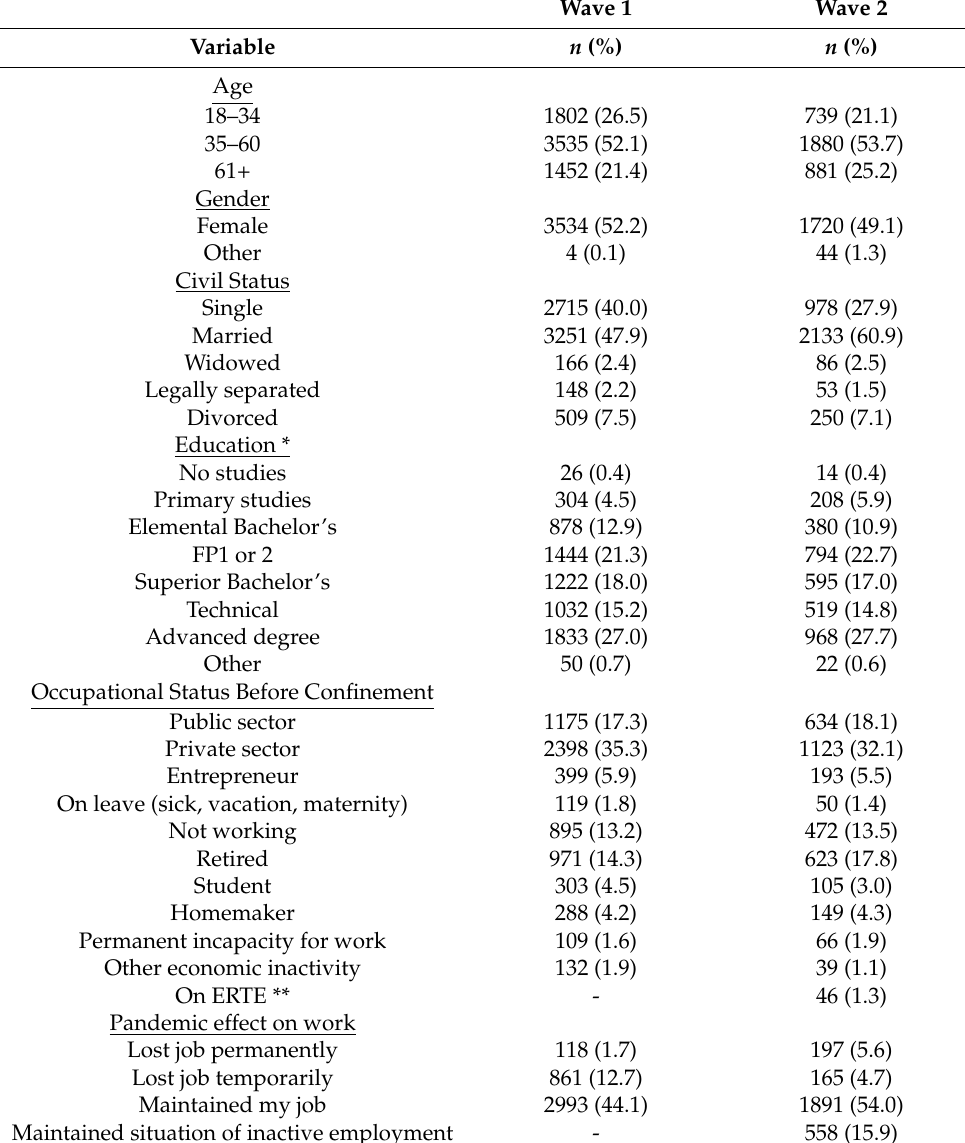
Table 3. Demographic characteristics of Wave 1 ( n = 6789) and Wave 2 ( n = 3500) survey participants. Wave 1 Wave